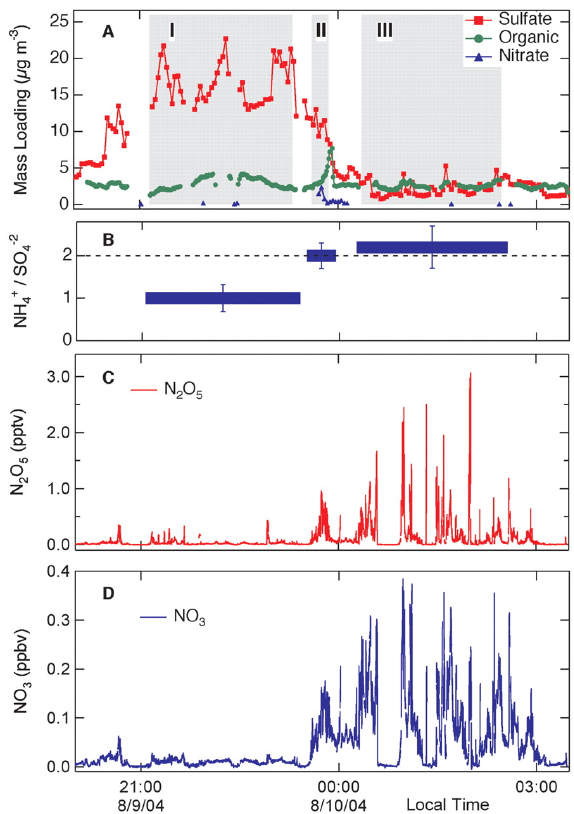
Figure 11. Measurements during a flight of the NOAA research aircraft P3 for 9 and 10 August 2004, showing the relationship be- tween NO 3 and N 2 O 5 concentrations and aerosol particle composi- tion (Brown et al., 2006).